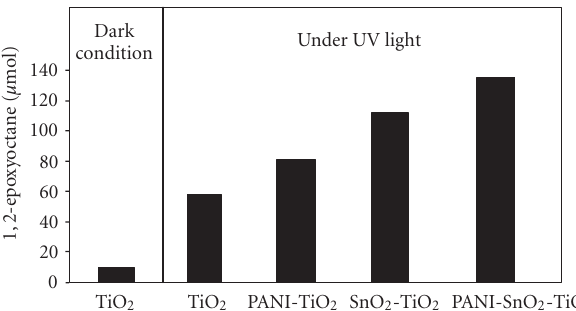
Figure 6: The photocatalytic epoxidation of 1-octene over PANI- SnO 2 − TiO 2 , SnO 2 − TiO 2 , PANI-TiO 2 , and TiO 2 . All reactions were carried out at 4 ◦ C under dark and UV light irradiation